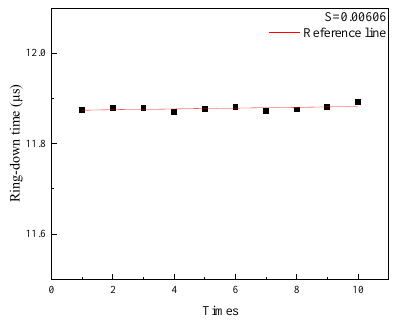
Figure 12. Stability test.